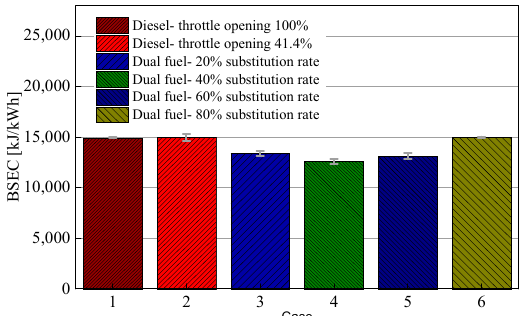
Figure 7. BSEC comparison with different substitution rates at 1600 rpm, 50.6 N·m.